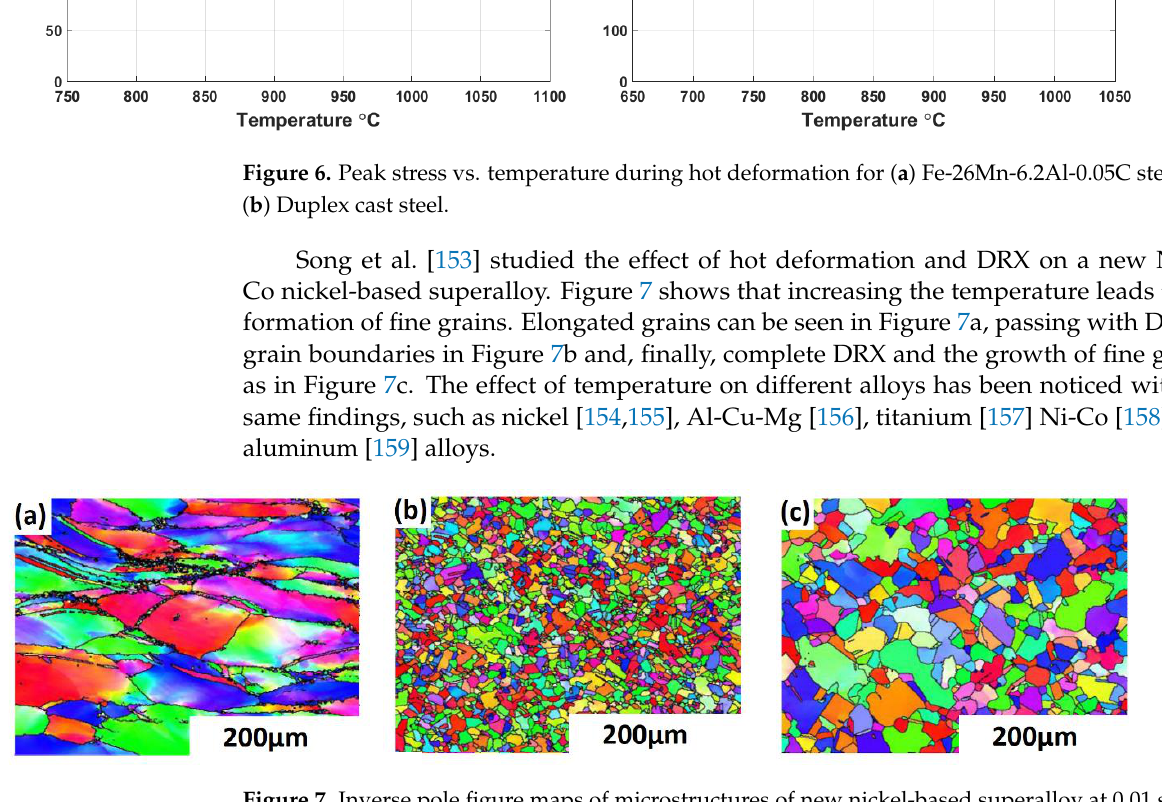
Figure 6. Peak stress vs. temperature during hot deformation for ( a ) Fe-26Mn-6.2Al-0.05C steel and ( b ) Duplex cast steel.